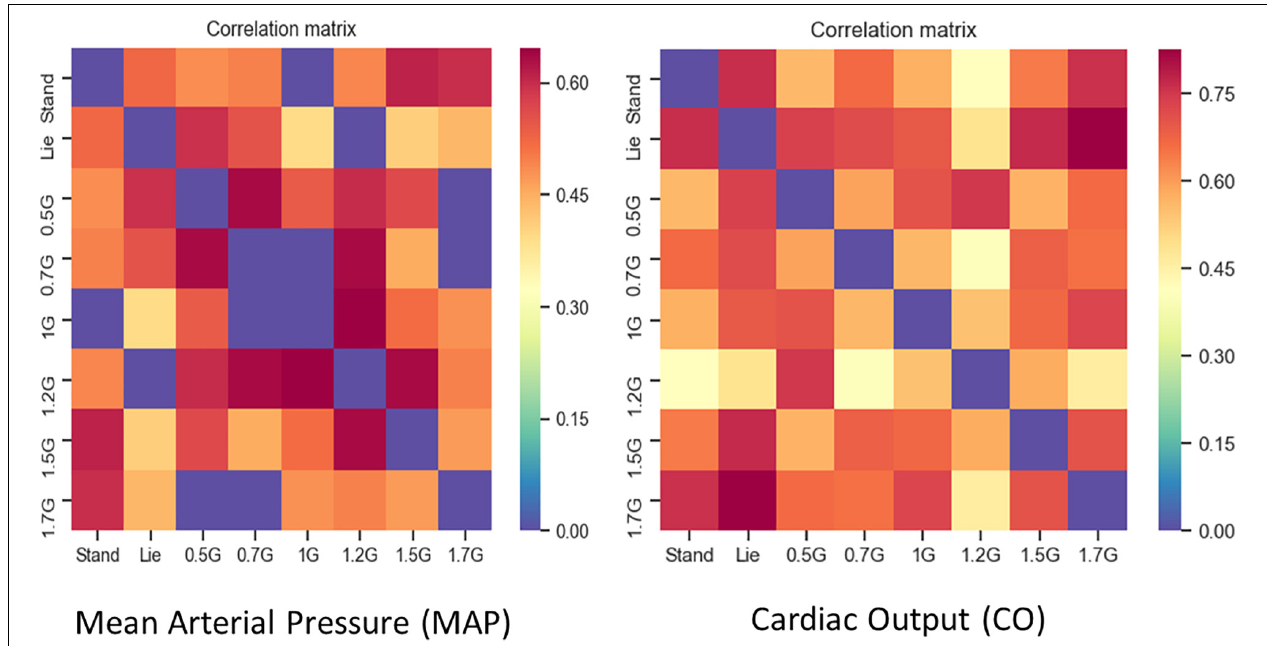
FIGURE 8 | Correlation Matrices for MAP (left picture) and CO (right picture) . ρ values with no statistical significance ( p > 0.05) were set to zero (blue). Furthermore, the main diagonal of the matrix was set to zero (blue) as well. Dark red in the correlation matrix represents the higher ρ s (0.7 for MAP and 0.8 for CO), blue represents the zeros, while the rest of the colors all values